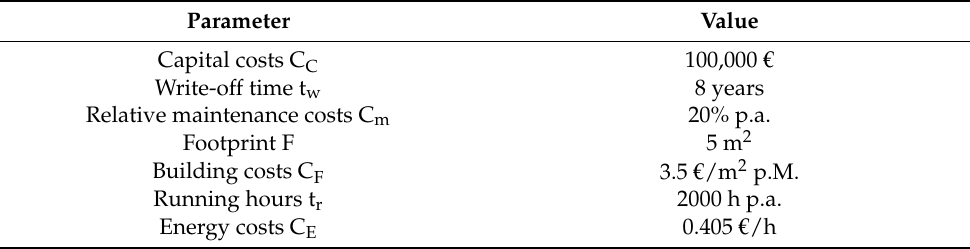
Table 1. Values for the laser cost calculation (reproduced from ref. [16] with kind permission of Trans Tech